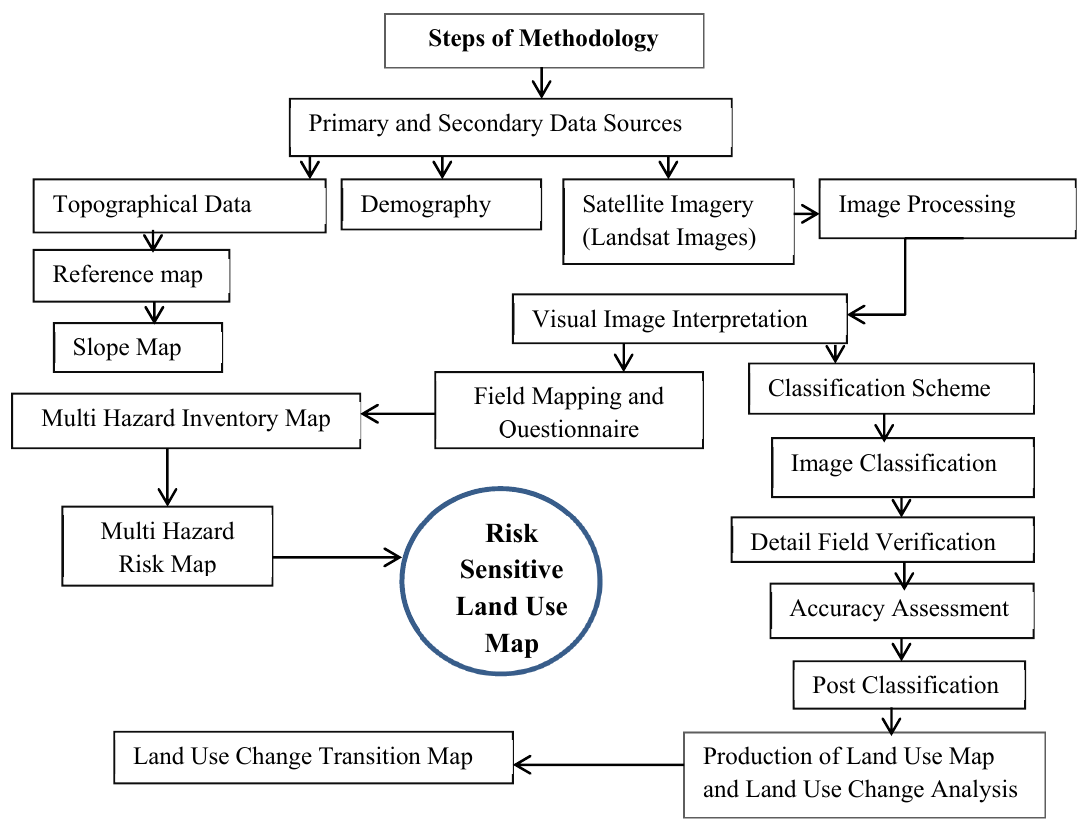
Figure 2. Flow chart showing the methodological